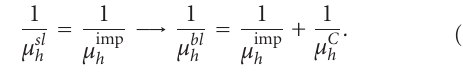
Figure 18(e) is an Arrhenius plot (ln ρ versus 1 /T ) for n = p = 9 × 10 10 cm − 2 , and the resistivity shows a good fit to an activated behaviour (It is di ffi cult to distinguish between a power law and an exponential rise as the insulating phase occurs over a small temperature range, less than one order of magnitude.) ( ρ xx ( T ) = ρ 0 e E/k B T ), yielding an energy gap of E/k B = 0 . 4 K. Similar analysis for the corresponding electron trace (data not shown) gives a far smaller gap of E/k B = 0 . 02 K. As the density is lowered (Figure 18) and the interaction strength is increased (larger r s ), the fit to an exponential rise becomes poorer. But the traces are expected to be (weakly) insulating for p < 6 × 10 10 cm − 2 , regardless of the presence of the electrons. The important result is the emergence of a strongly insulating state at large k F (cid:9) ( ρ xx (cid:8) h/e 2 ). In Figure 19, ρ xx ( T ) for both layers appears to saturate at the lowest temperatures. This is likely to an artefact of the electron temperature not reaching the